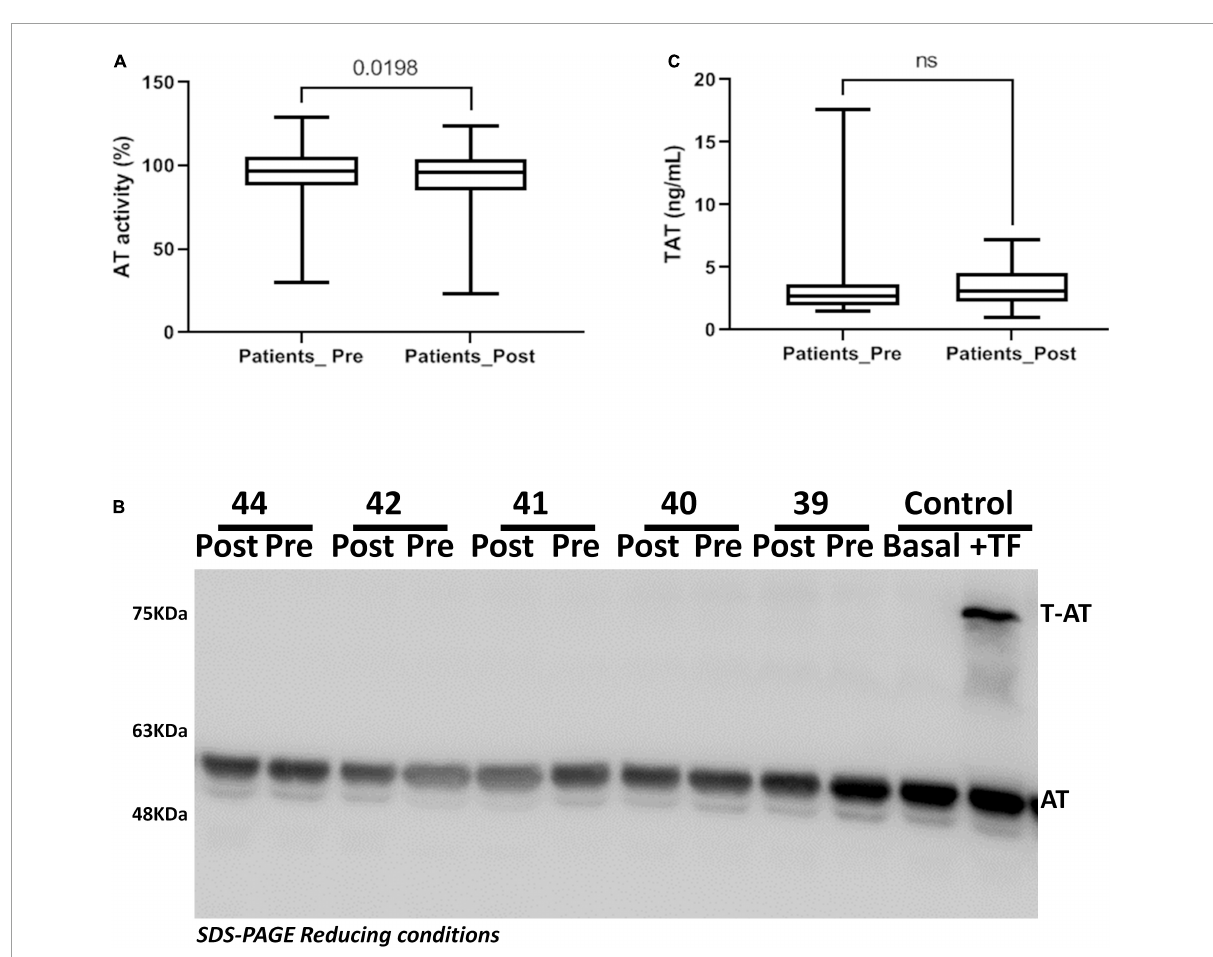
FIGURE6 Antithrombin activity in patients underwent transcatheter aortic valve replacement. (A) Anti-FXa activity. (B) Thrombin-Antithrombin complexes quantified by ELISA. (C) Plasma antithrombin detected by Western blot. Representative samples are